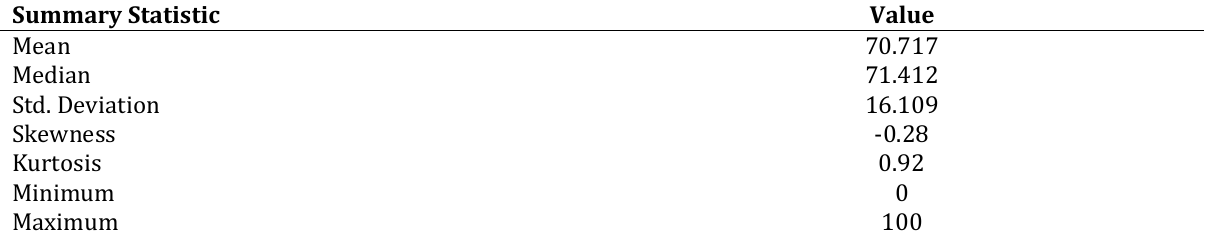
Table 6: Summary statistics of the level of sensitivity for machine